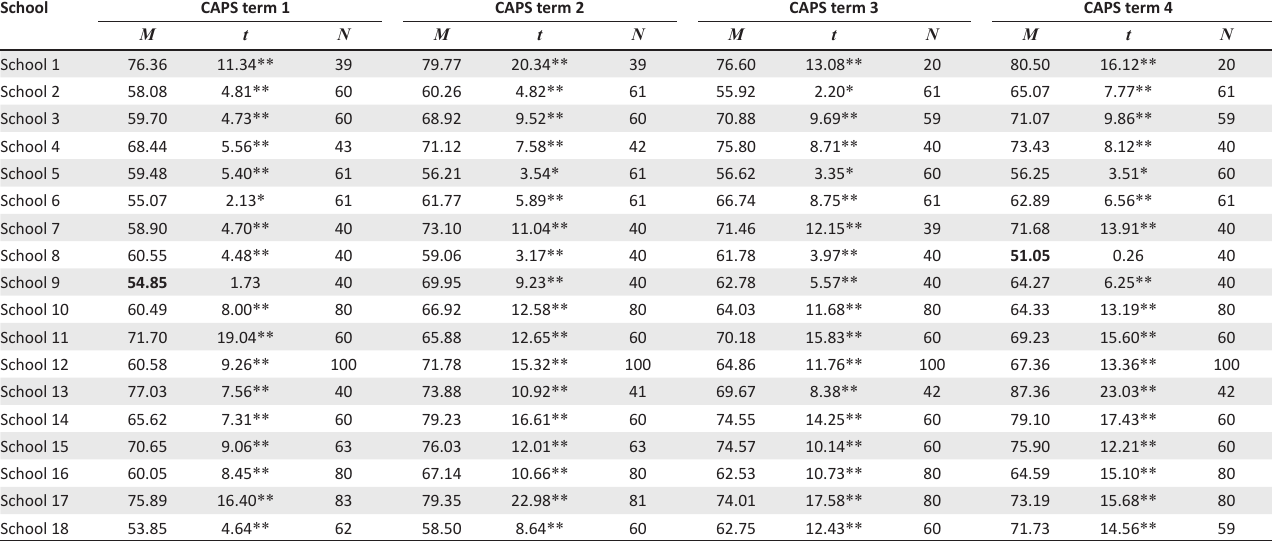
TABLE 4: School performance against Department of Basic Education’s standards for English first language (50 % ).